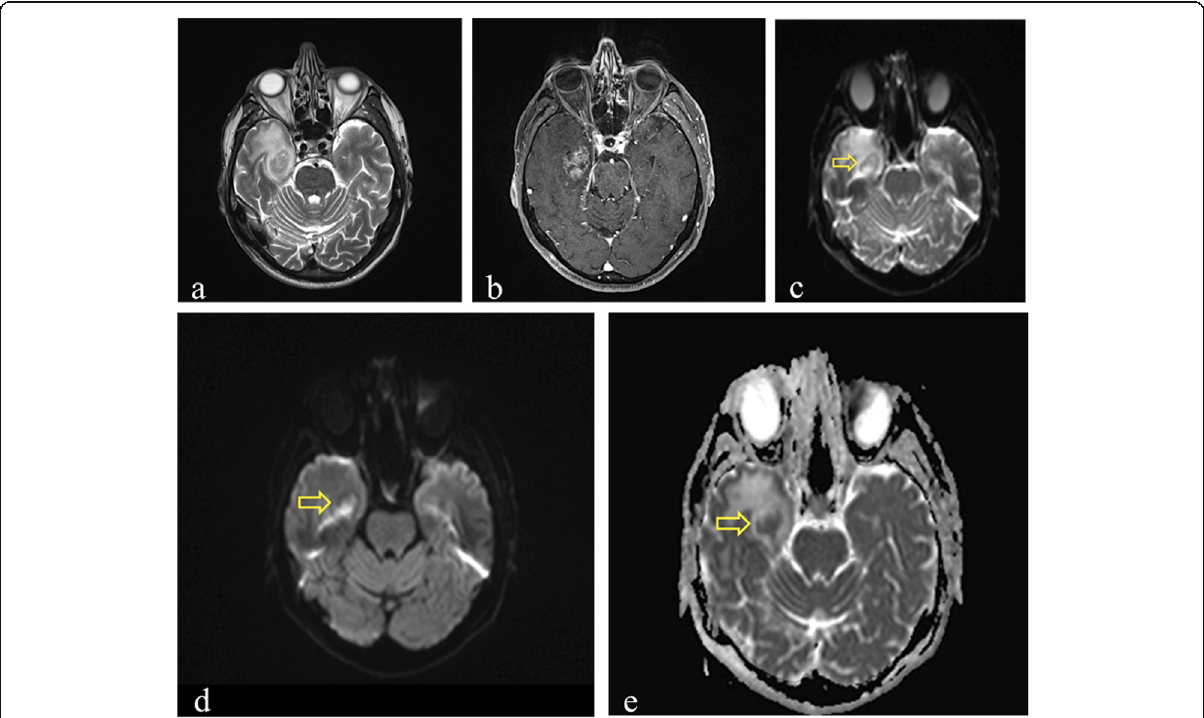
Fig. 7 MRI performed 18 months after 65.6 Gy carbon ion therapy in a patient with sinonasal adenoid cystic carcinoma. Axial T2-weighted image ( a ) shows a subcortical white matter and gray matter lesion in right polar and mesial temporal regions. Axial post contrast T1-weighted image ( b ) shows the presence of inhomogeneous contrast-enhancing lesion. Diffusion imaging documented the presence of foci of restricted diffusion within the medial part of the lesion appearing as hyperintense areas in DWI- b0 ( c ) and DWI- b1000 images ( d ) and hypointense on the corresponding ADC map ( e ) (yellow